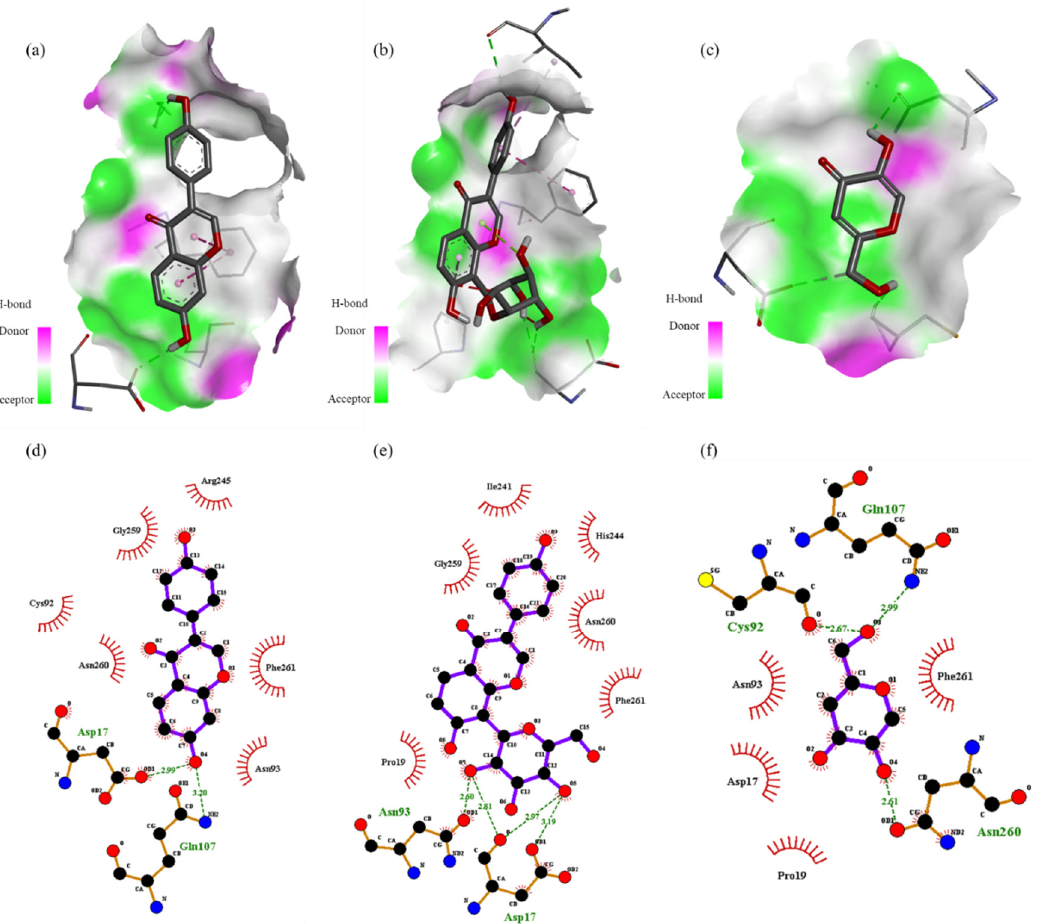
Figure 5. Hydrogen-bonding pocket view of the binding location of daidzin ( a ), puerarin ( b ), and kojic acid ( c ) and predicted binding positions between human tyrosinase (PDB ID:1BUG) and daidzin ( d ), puerarin ( e ), and kojic acid ( f ).